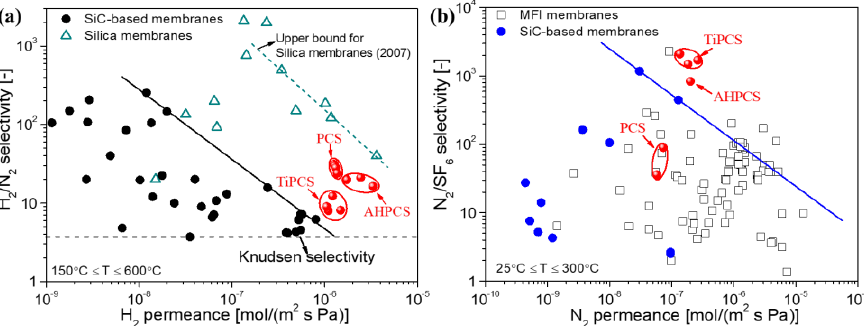
Figure 23. Comparison of the selectivities for ( a ) H 2 /N 2 and ( b ) N 2 /SF 6 by various membranes [72,73,82] .